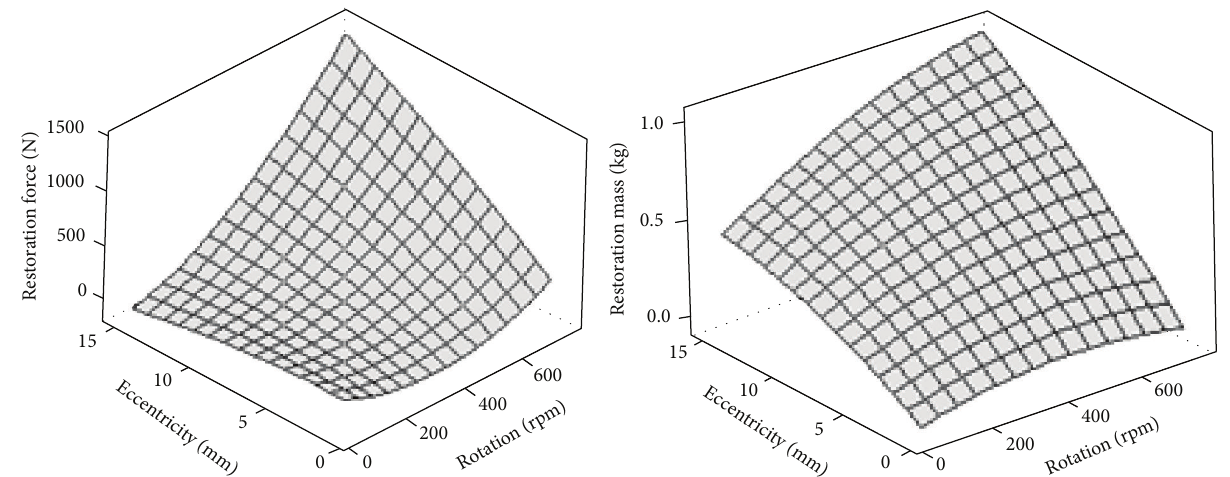
Figure 7: Response surface of steady state study correlating rotation speed (rpm), eccentricity (mm), restoration force (N), and restoration mass